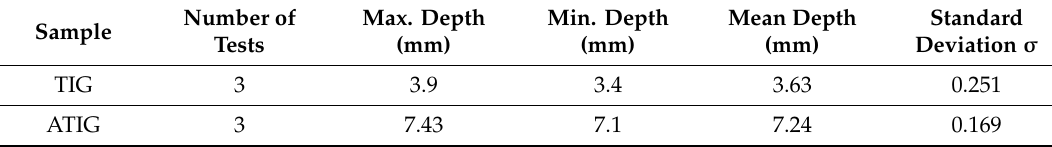
Table 4. Mesurments of depth and standards deviation of TIG and ATIG (optimal